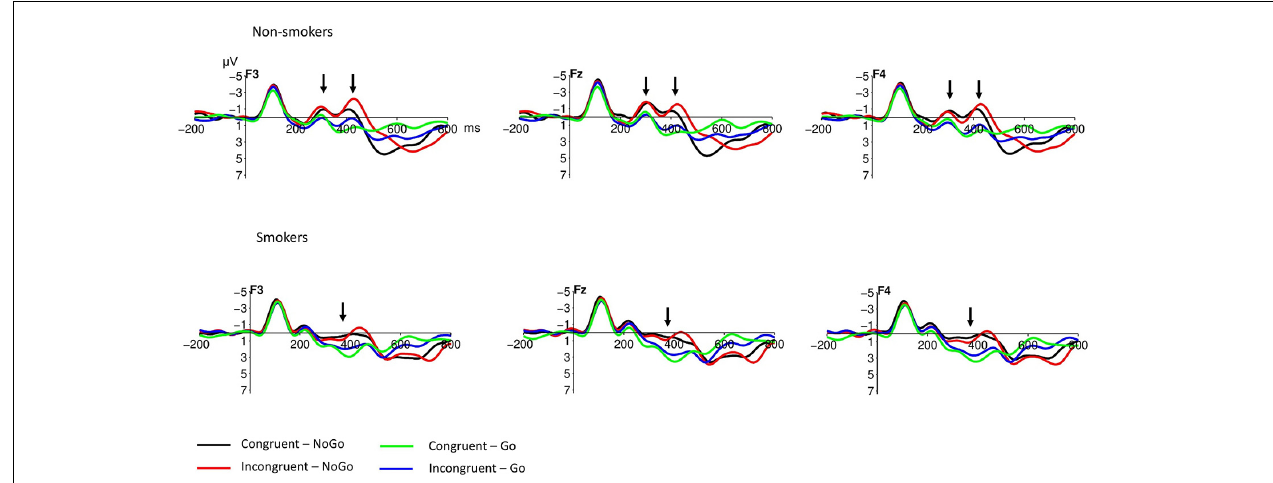
FIGURE 3 | Stimulus-locked grand average event-related potential (ERP) waveforms at frontal electrode sites after the presentation of smoking-related pictures; for non-smokers and smokers. Note that the NoGo N200 seems to have two peaks, the second being delayed in the incongruent compared to the congruent condition—but only in the non-smoker, not in the smoker group ( pointing arrows ). The baseline used is − 100 to 0 ms. The displayed waveforms were filtered with a 12 Hz low-pass filter.